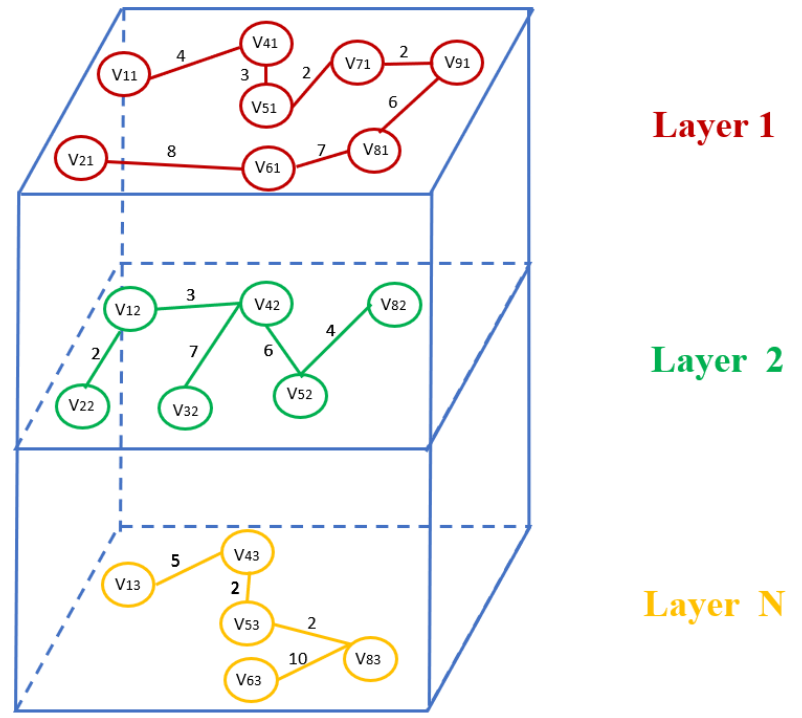
Figure 1. Original multilayer data transmission network .